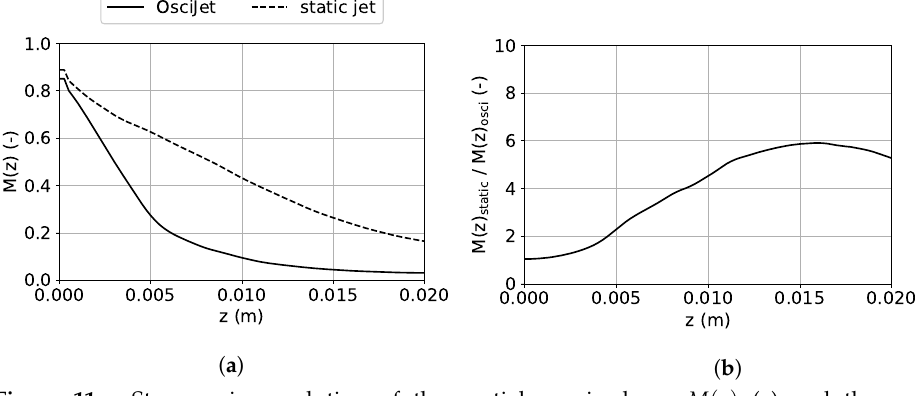
Figure 11. Stream-wise evolution of the spatial unmixedness M ( z ) ( a ) and the quotient M ( z ) static / M ( z ) osci ( b